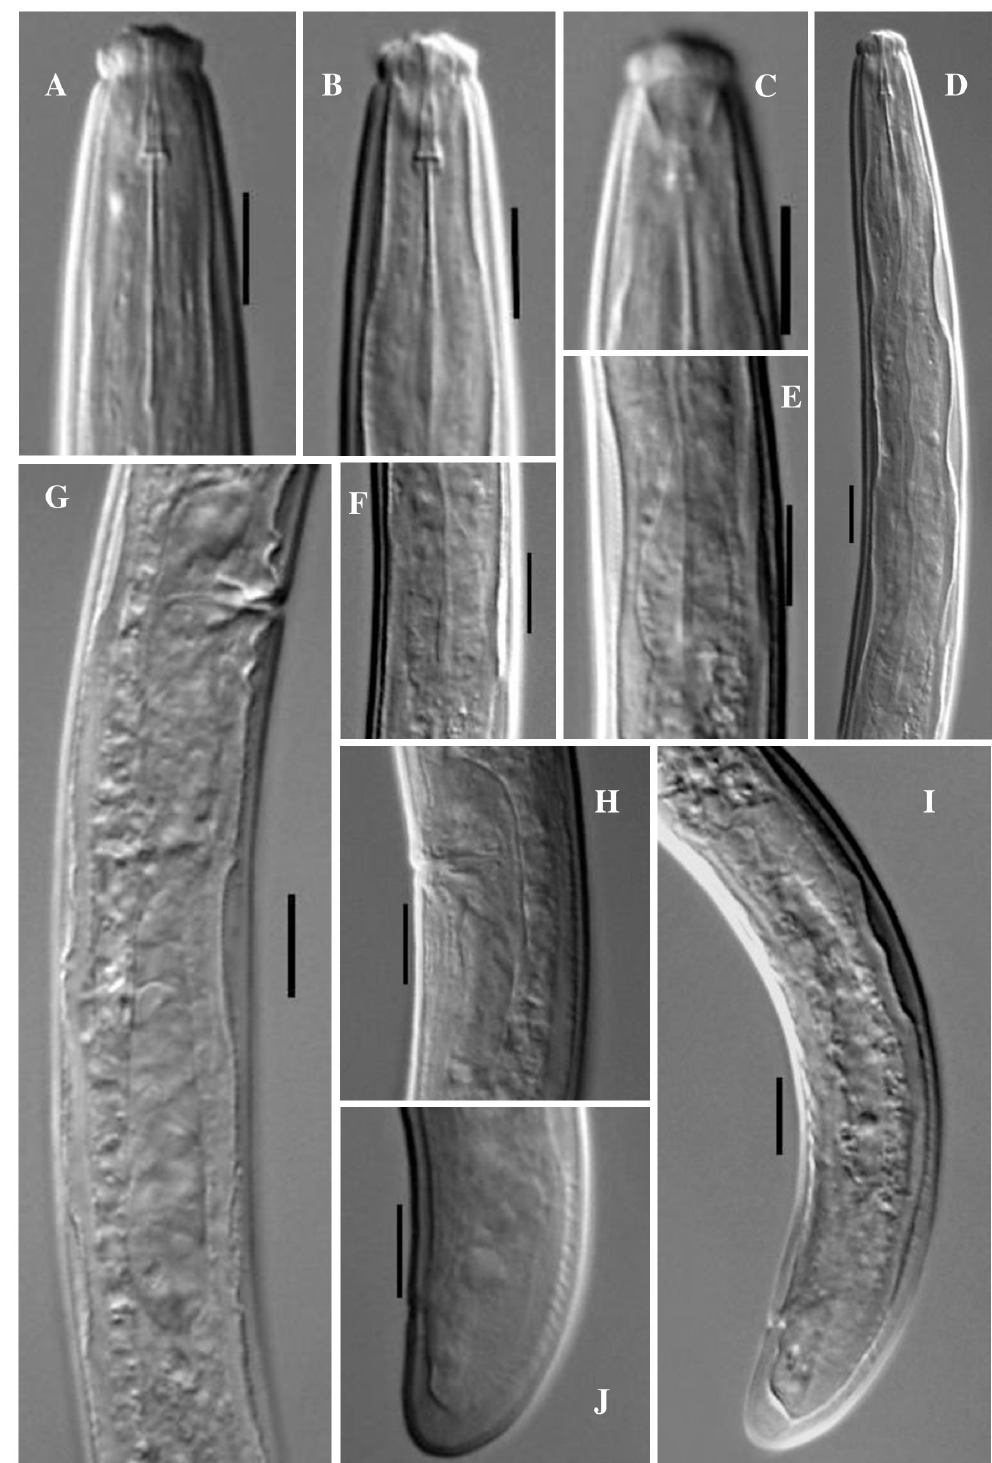
Fig. 2. Basirotyleptus pini Siddiqi & Khan, 1964, ♀ (AMU/ZD/NC/ Basirotyleptus pini /1–3) (LM photographs). A–B . Anterior region. C . Anterior region showing amphid. D . Pharyngeal region. E–F . Pharyngeal bulb. G . Genital system. H . Vulval region. I . Posterior region. J . Posterior end. Scale bars =10